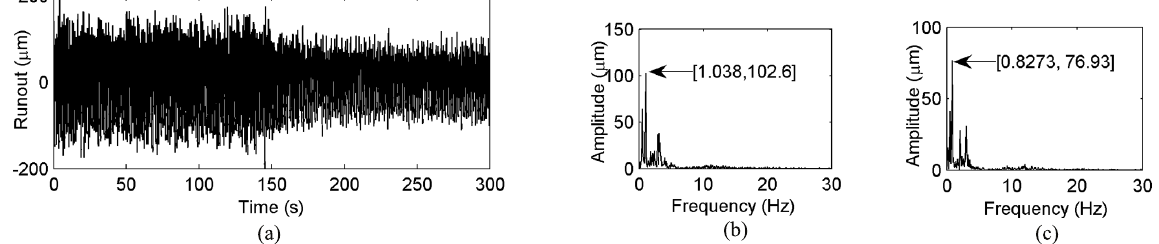
Fig. 7. Field data under rotating speed test at UGB direction X, (a) Time history; (b) Spectra of the first half part (1 × n r ) ; (c) Spectra of the second half part (0.8 × n r ) .